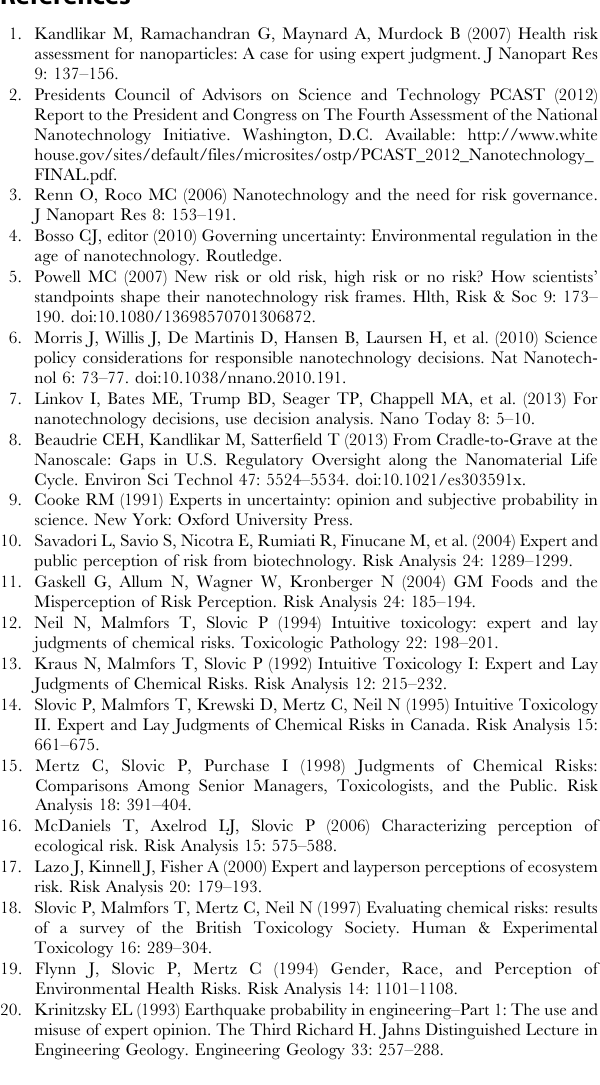
Table S1 One-Way Analysis of Variance (ANOVA) measuring significance of differences in mean Risk Perceptions by expert group for 14 nanotechnology scenarios (scale: ‘1- almost no risk’, ‘2 –slight risk’, ‘3